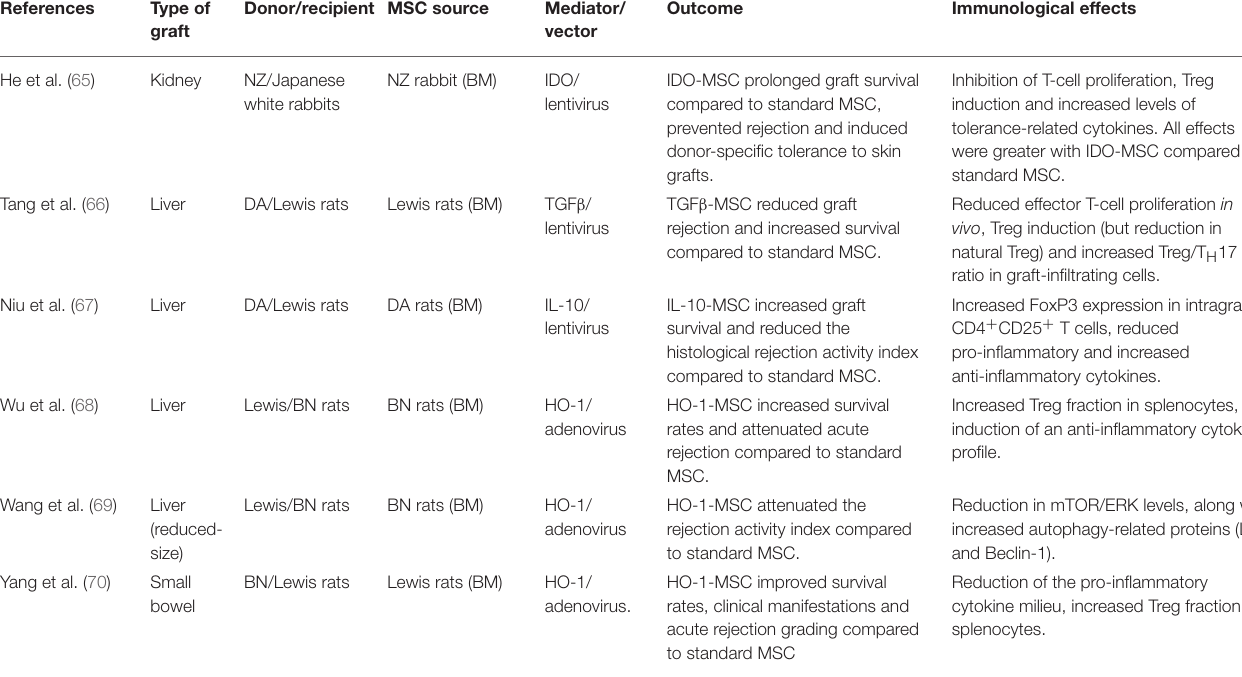
TABLE 2 | Preclinical data on genetically-engineered MSC in solid organ